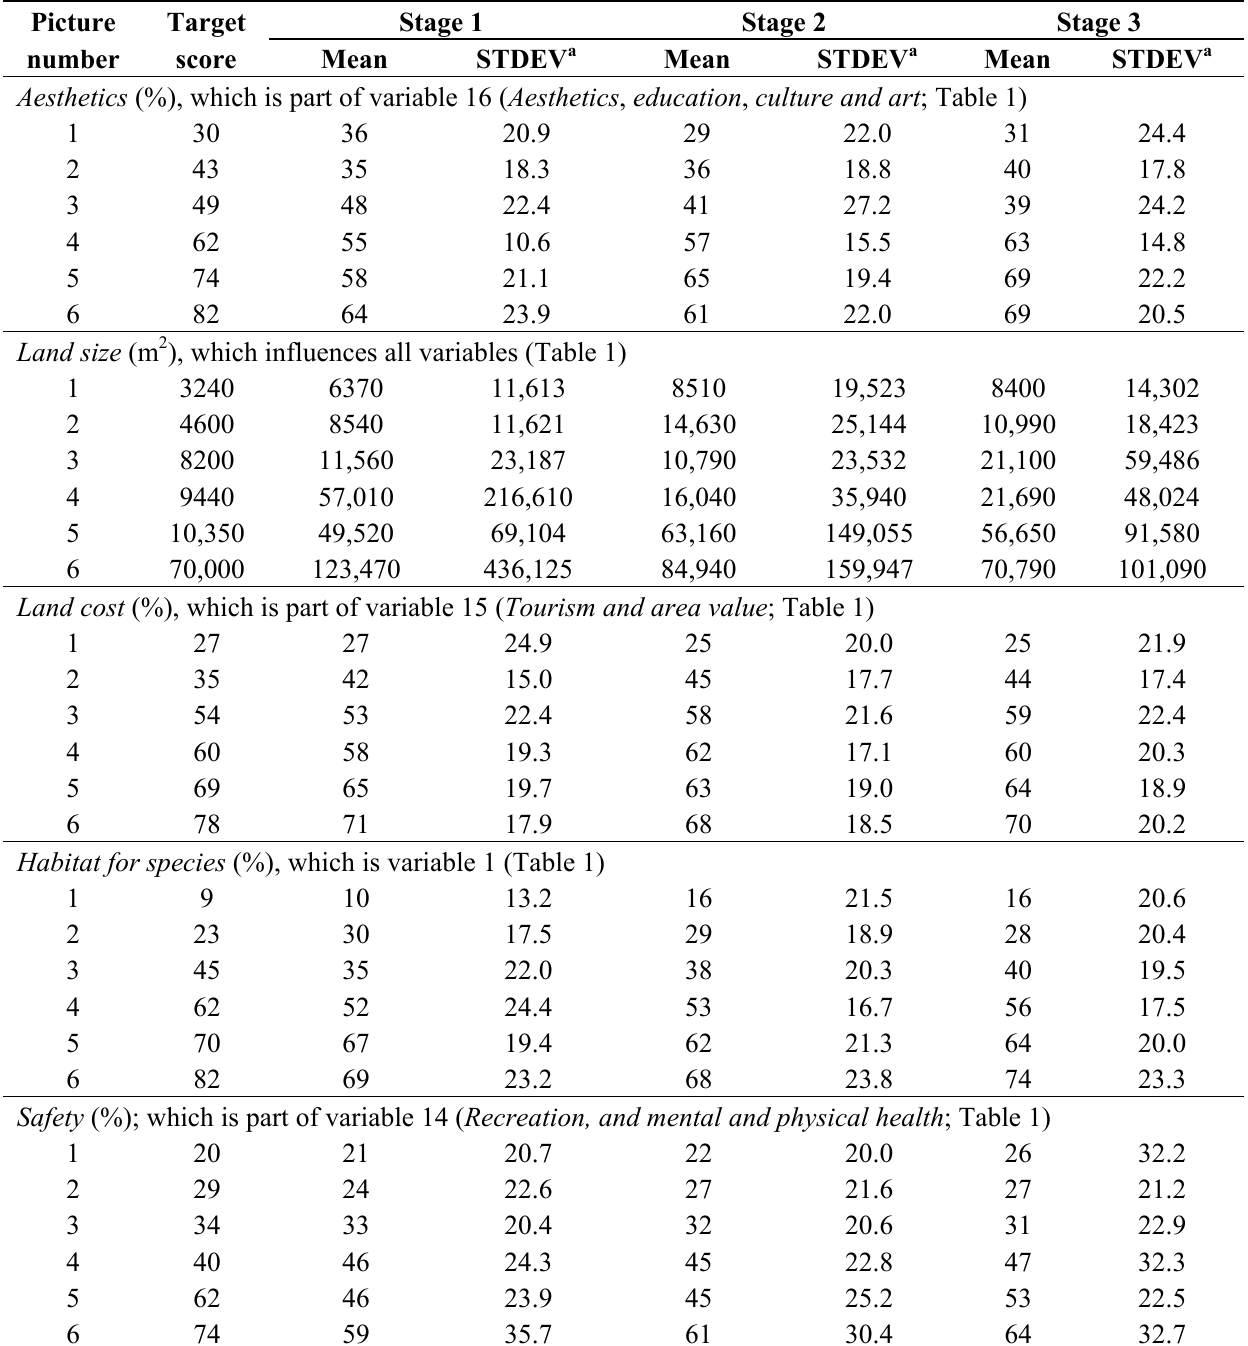
Table 6. Summary of the questionnaire analysis* for the civil engineering student